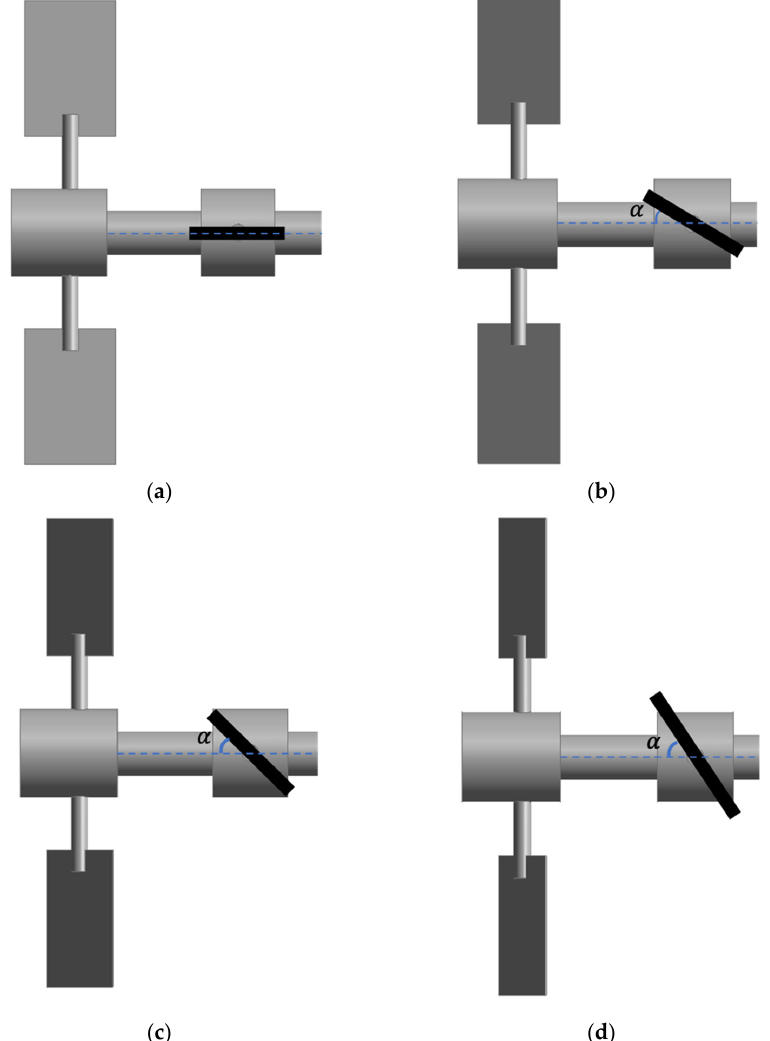
Figure 3. Schematic of various configurations for paddle angle ( a ) 𝜶 = 0°, ( b ) 𝜶 = 30°, ( c ) 𝜶 = 45° and ( d ) 𝜶 = 60°.